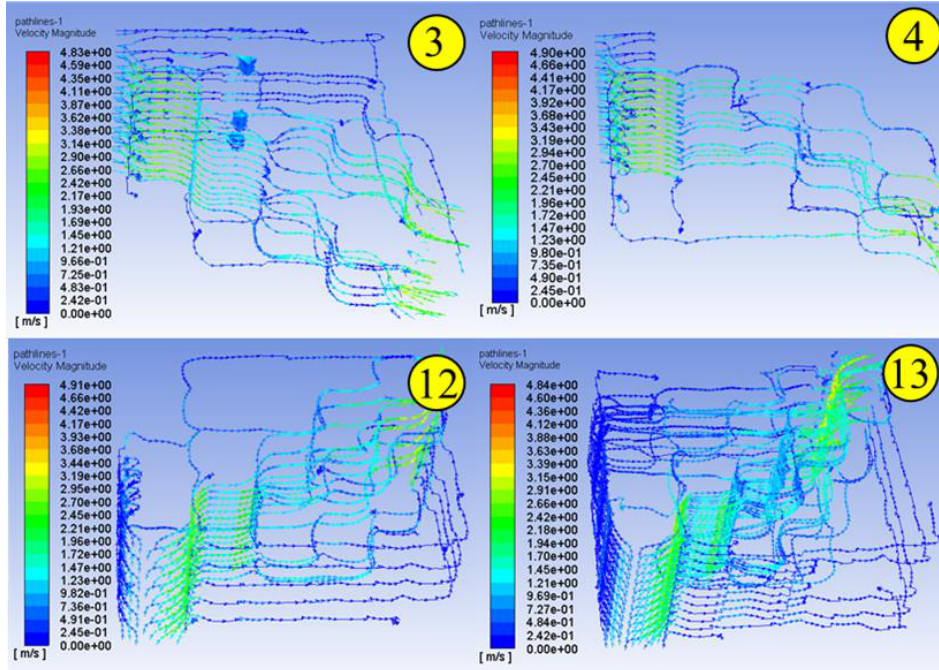
Figure 16. Velocity path line of scheme 3, 4, 12, 13.